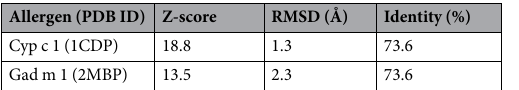
Table 2. Structural similarity of Sco j 1 to other